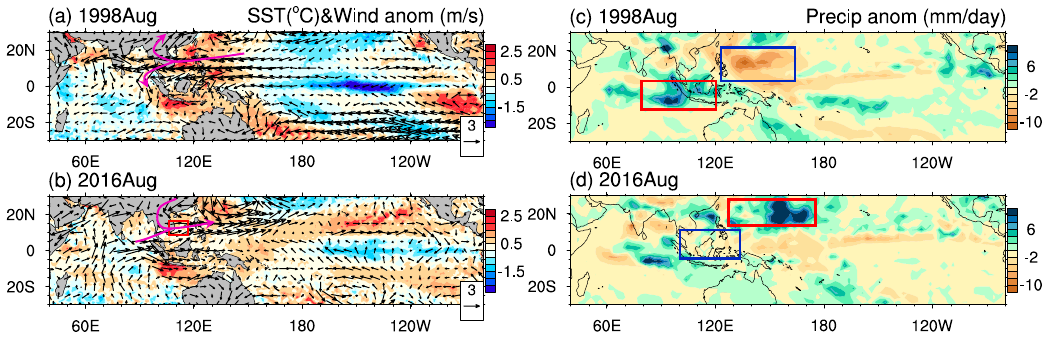
Figure 7. August SST anomalies (SSTa) (shading, units: ◦ C) and surface wind (vector, units: m / s) anomalies in ( a ) 1998 and ( b ) 2016. ( c )–( d ) Same as in ( a )–( b ) but for the results of the rainfall anomalies (shading, units: mm / day). Red and blue rectangles in ( c )–( d ) indicate the excessive and suppressed precipitation, respectively.